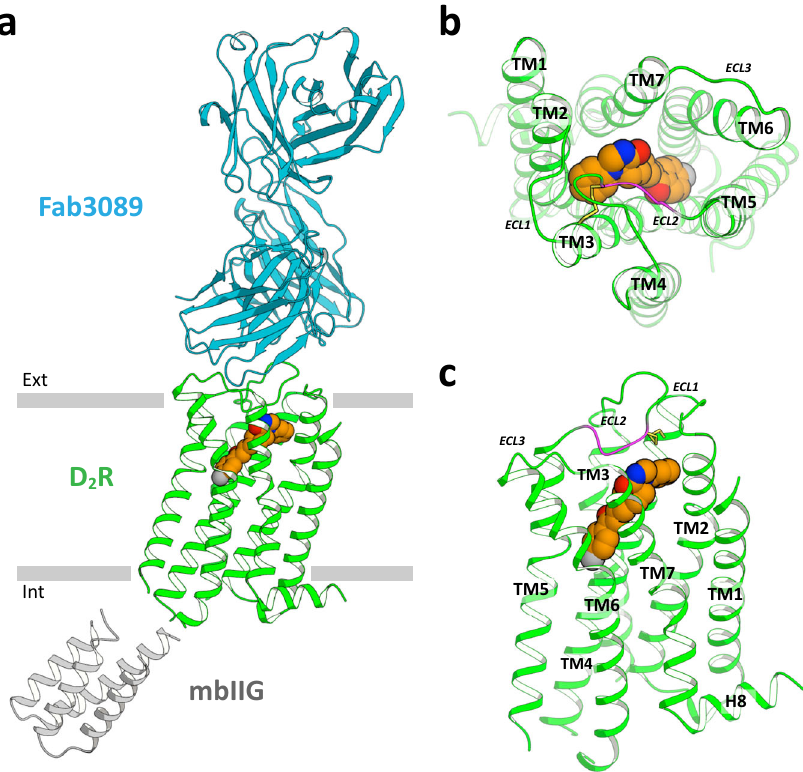
Fig. 1 Structure of D 2 R spi in complex with spiperone. a Overall structure of D 2 R spi -Fab 3089 complex. Extracellular ( b ) and side ( c ) views of D 2 R spi . Spiperone, D 2 R, Fab3089, and mbIIG are indicated in orange, green, cyan, and gray, respectively. The disul fi de bond and the C-terminal segment of ECL2 are shown in yellow and magenta, respectively, in ( b ) and ( c ). Ext, extracellular; Int, intracellular.